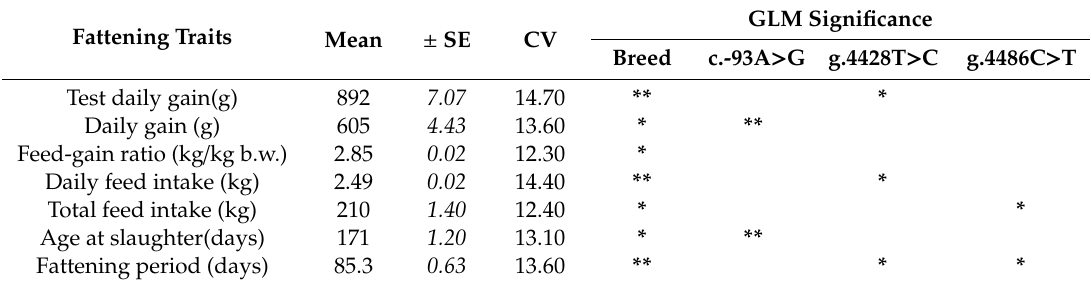
Fattening period (days)